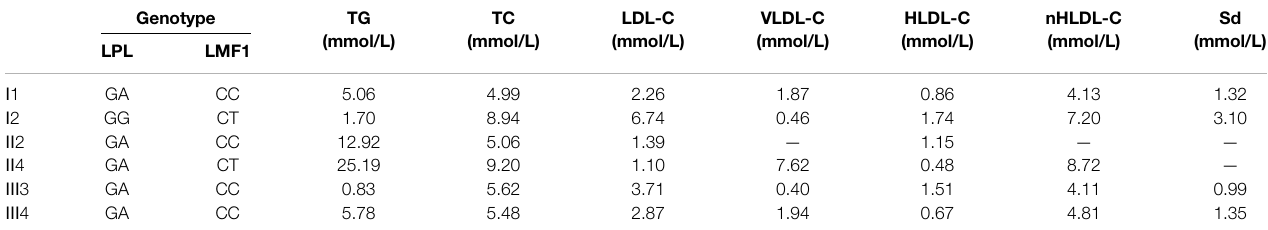
TABLE 1 | plasma triglyceride levels in the proband and his relatives. Genotype